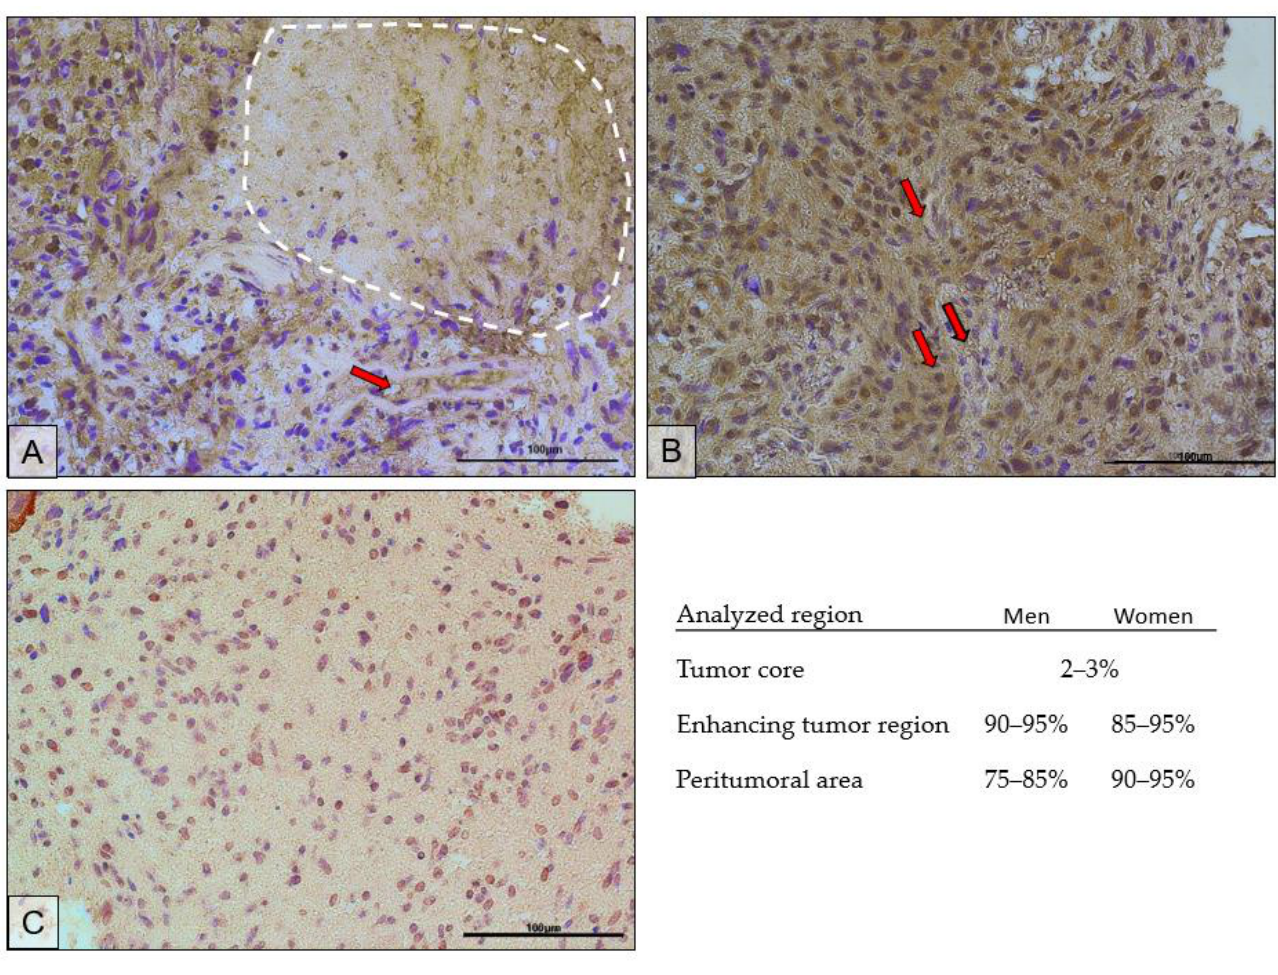
Figure 8. Representative microphotographs show AR protein expression in the tumor core (the necrotic area is circled with a white dotted line) ( A ), enhancing tumor region ( B ), and peritumoral area ( C ) of a tumor diagnosed as GBM. Exemplary blood vessels are marked with red arrows. Microphotographs were taken at ×40 magnification; scale bar 100 µm.